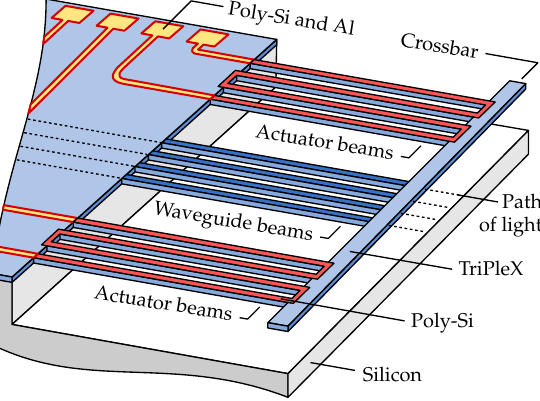
Figure 2. Schematic representation of a suspended positionable waveguide array with waveguide beams in the center and out-of-plane actuator beams on both